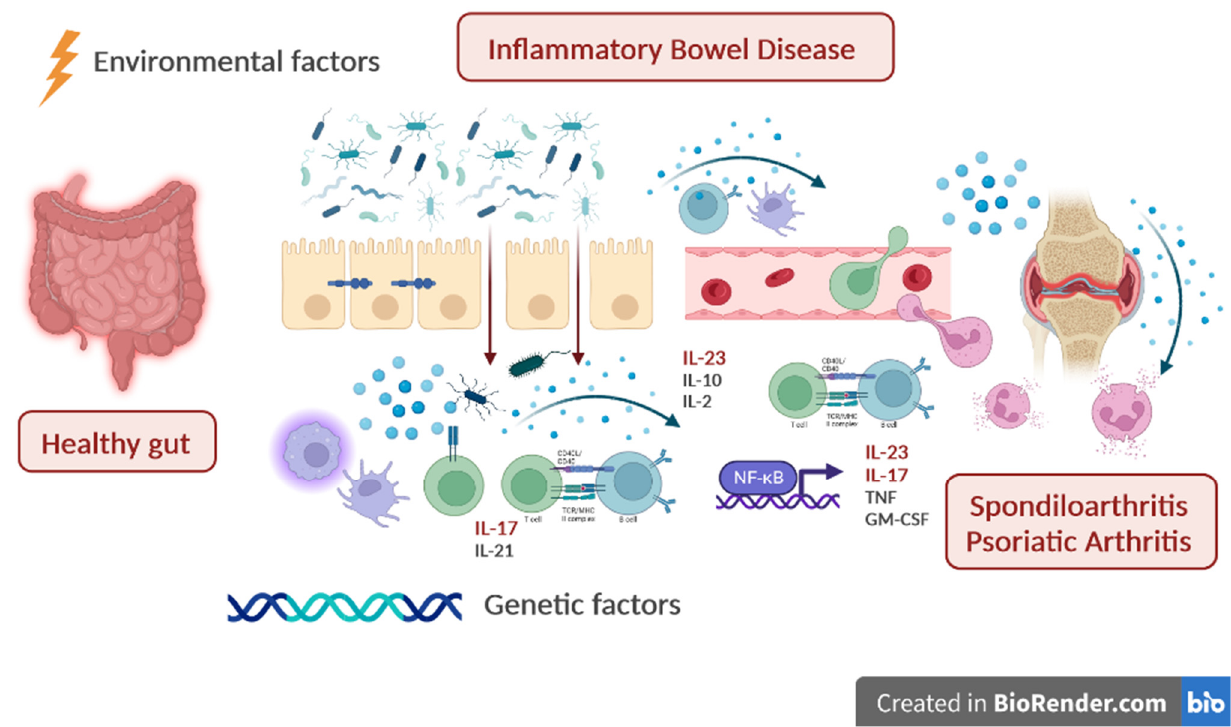
Figure 2. The gut–joint axis in the pathogenesis of IBD and SpA/PsA. Immunological changes in the gut–joint axis: genetic predisposition, environmental factors, and dysbiosis contribute to the loss of intestinal permeability, with consequent activation of immune cells and production of cytokines (i.e., TNF, IL-23, and IL-17), which stimulate chronic inflammation and migration of leukocytes from the gut toward the joints.